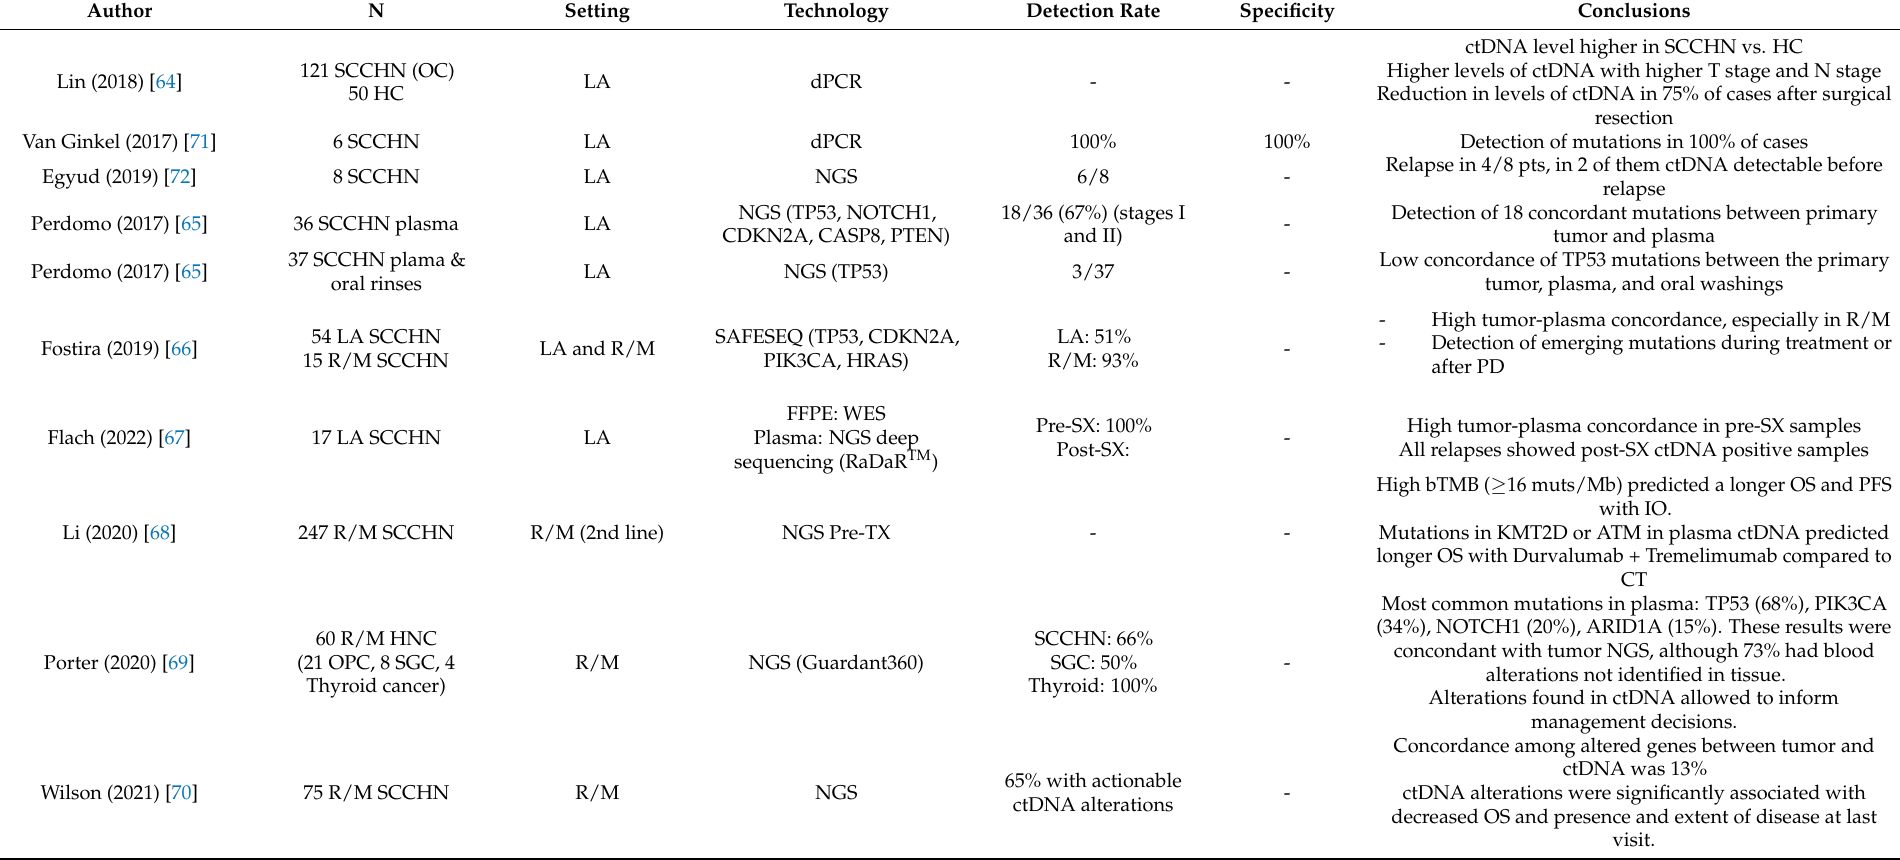
Table 3. Most relevant studies with ctDNA in patients with HPV-unrelated